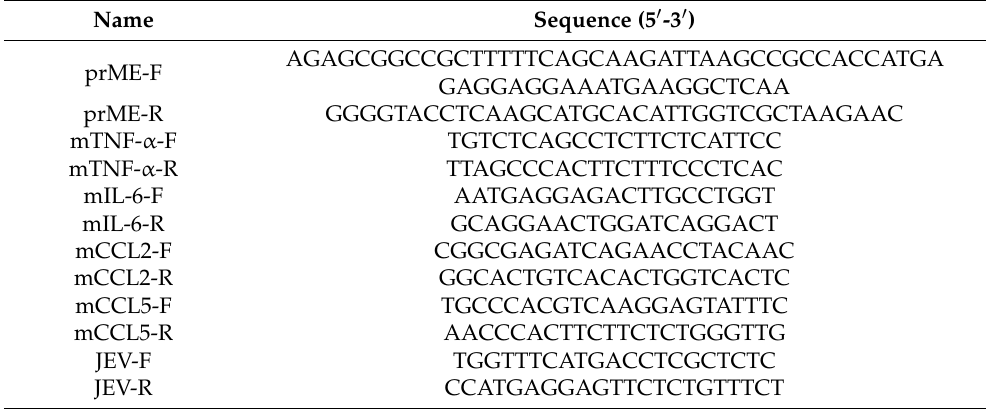
Table 1. Primers used in this